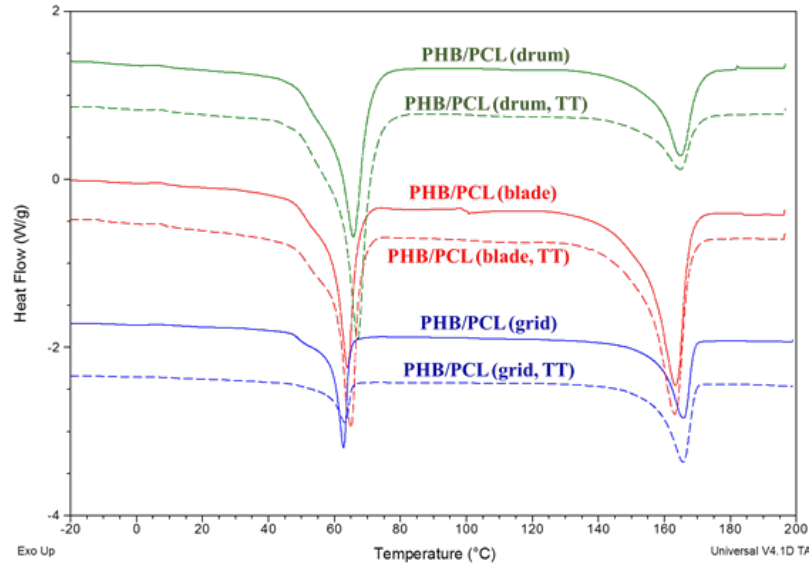
Figure 7. DSC thermograms (first heating run) of the PHB/PCL mats before (solid lines) and after (dash lines) thermal treatment onto rotating drum (green), blade (red) and grid (blue) collectors.